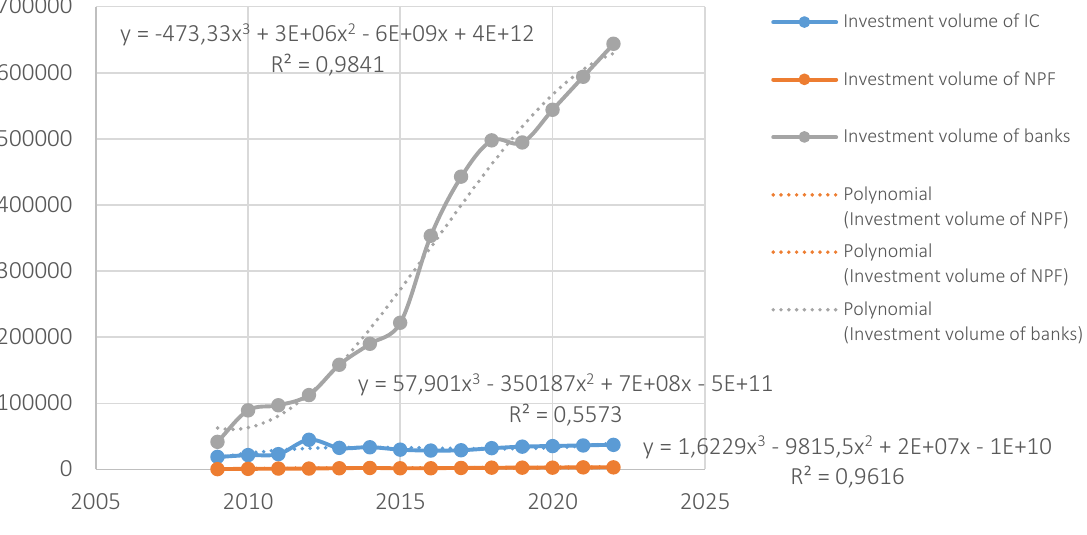
Figure 3. Forecasting the volume of investment by financial intermediaries for